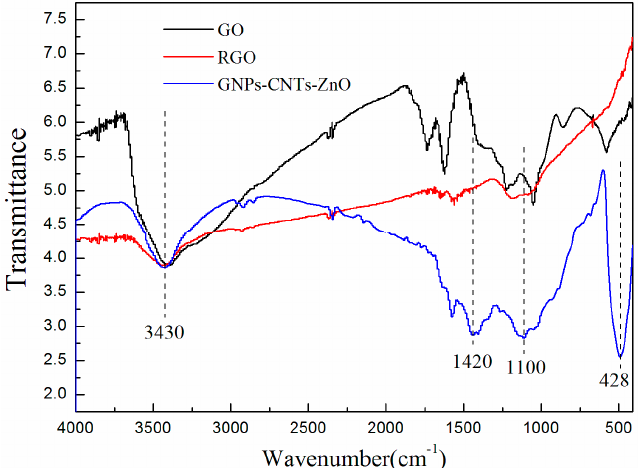
Figure 4. FTIR spectrums of GO, reduced graphene oxide (RGO), and GNPs-CNTs-ZnO hybrid.